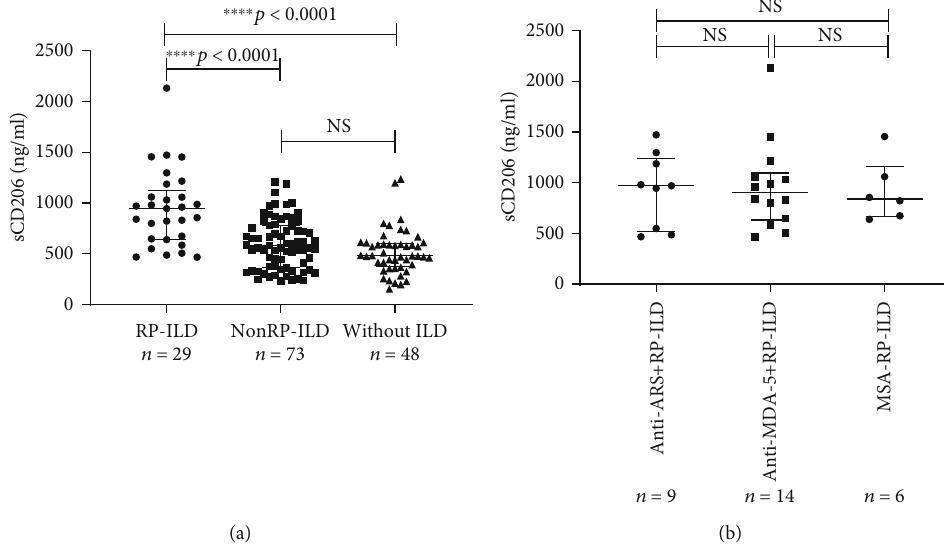
Figure 2: The sCD206 levels in all DM patients and in those with RP-ILD with di ff erent MSAs. (a) The serum levels of sCD206 in DM patients with RP-ILD, nonRP-ILD, and those without ILD. (b) The serum levels of sCD206 in DM patients with RP-ILD classi fi ed based on di ff erent MSAs. sCD206: soluble CD206; DM: dermatomyositis; ILD: interstitial lung disease; RP-ILD: rapidly progressive interstitial lung disease; ARS: aminoacyl-tRNA synthetases; MDA-5: melanoma di ff erentiation-associated gene-5; MSA: myositis-speci fi c autoantibodies. The Kruskal-Wallis H test was applied for comparisons between three groups. Error bars represent the interquartile range. NS indicates no signi fi cant di ff